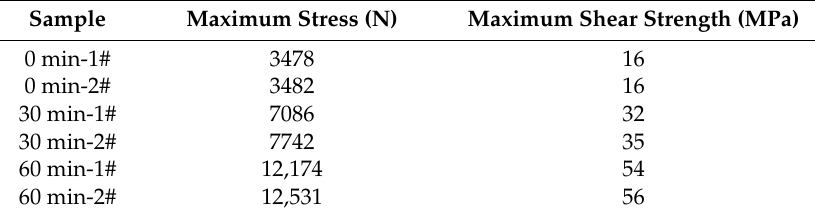
Figure 7. Load-displacement curves obtained of the Mg-9Al/Ti metallurgical bonding by push-out testing for 0 min, 30 min and 60 min at 700 °C. Table 1. Shear strength of Mg-9Al/Ti metallurgical bonding with different heat treatment time.